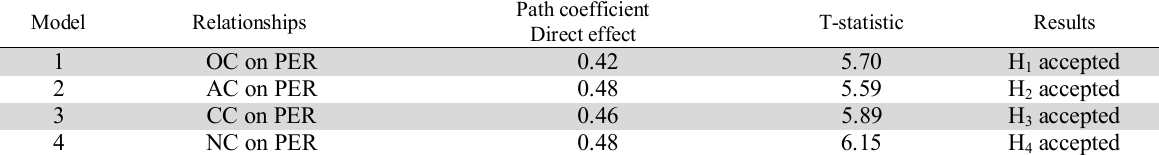
The effects of commitment dimensions on employee's